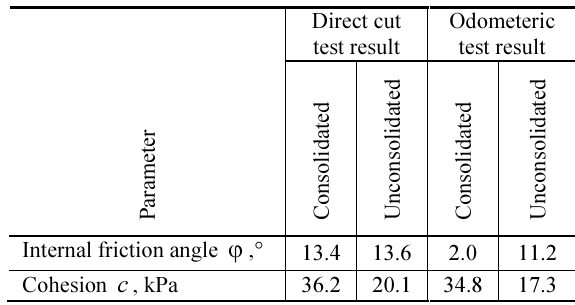
Fig. 5. Example of k – 0 / H H relationship graph